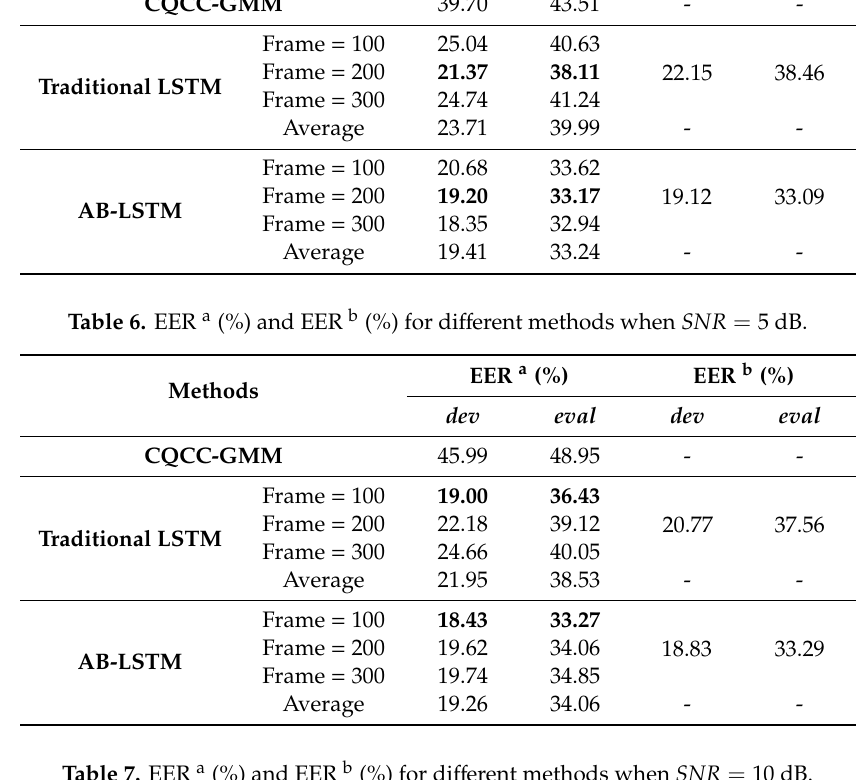
Table 7. EER a (%) and EER b (%) for di ff erent methods when SNR = 10